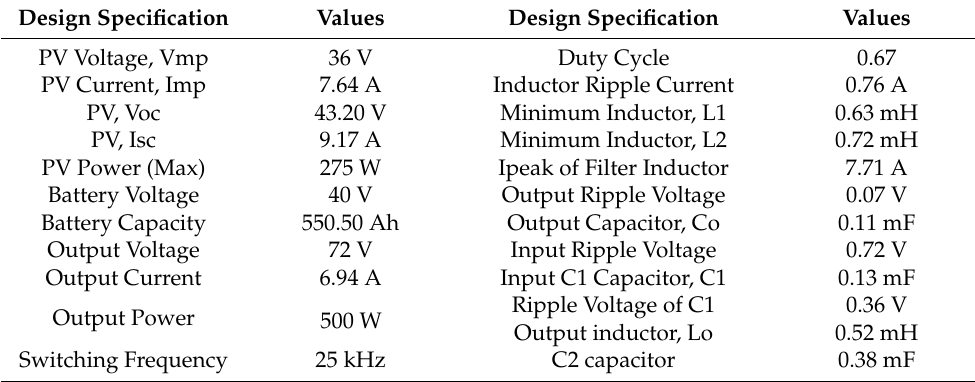
Table 1. Design specifications for the proposed MPC.